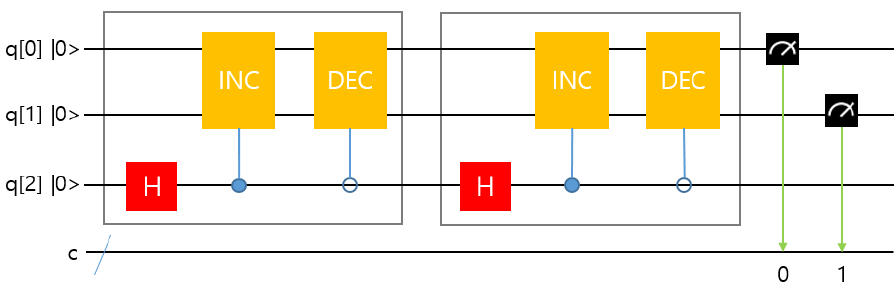
Figure 18. Circuit with an implemented quantum random walk.